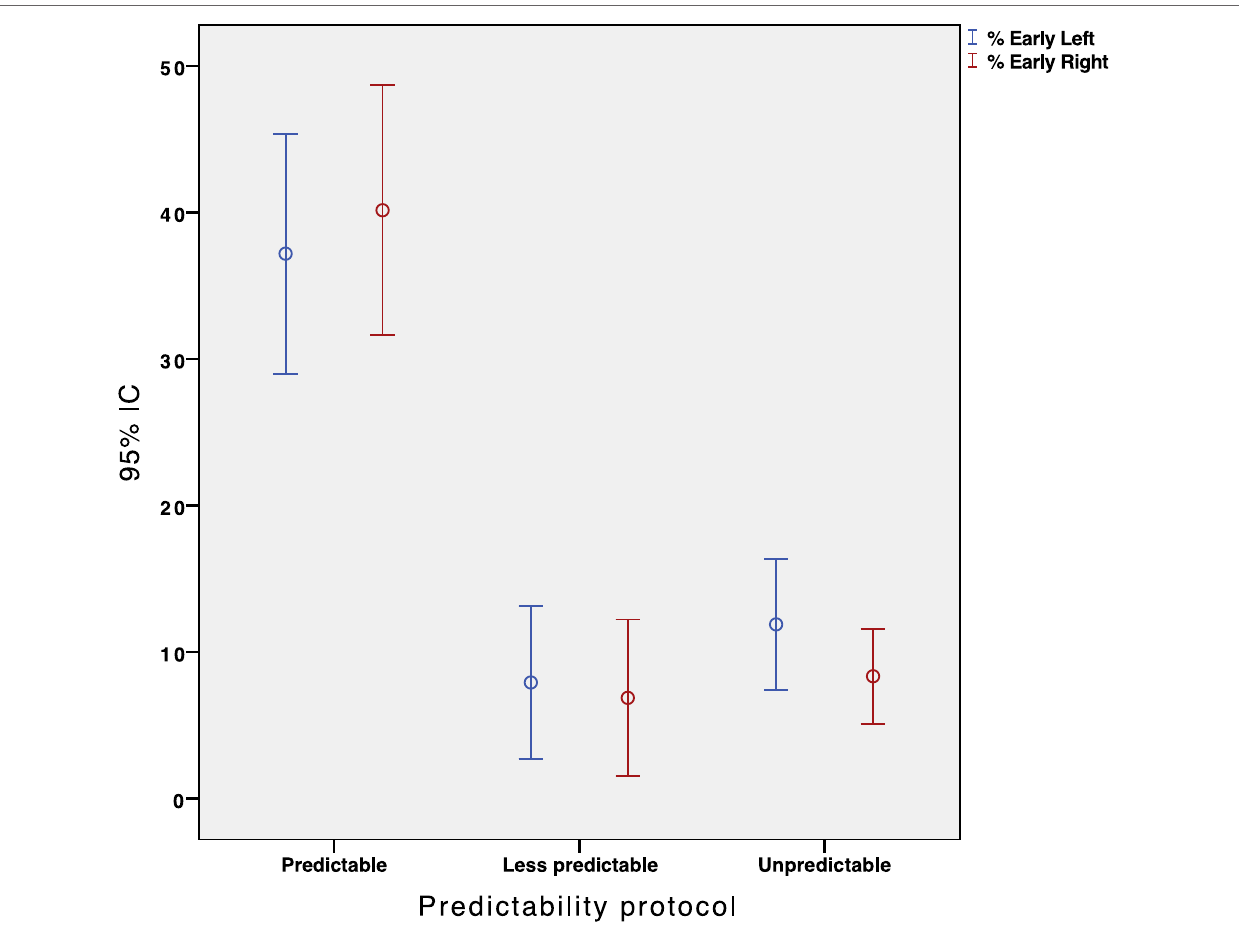
FigUre 5 | Error Bar’s graph representing the percentage of early eye saccades obtained in our population depending on the protocol performed. Red and blue color represent the right and left sided impulses,